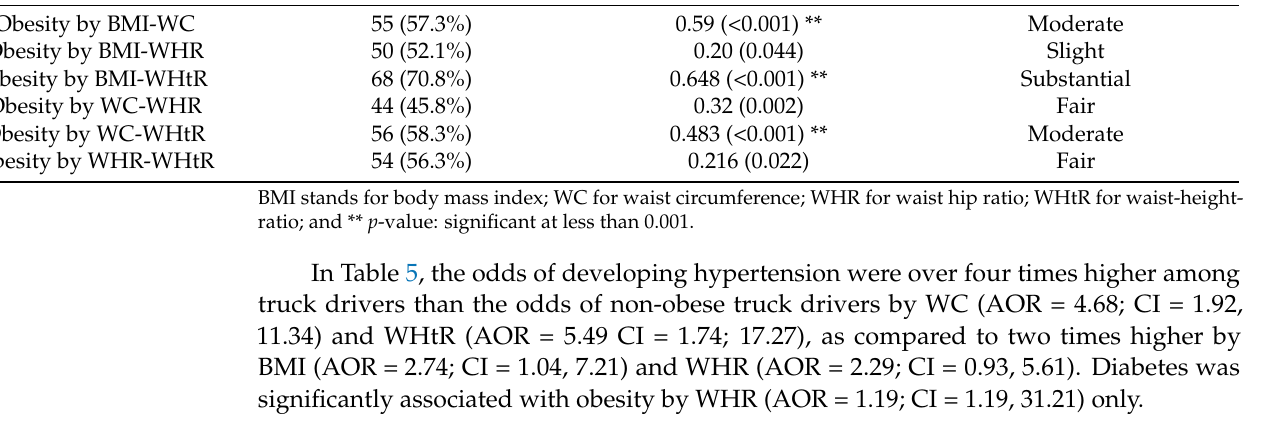
Table 5. Adjusted associations between hypertension, diabetes, and classification of obesity among truck